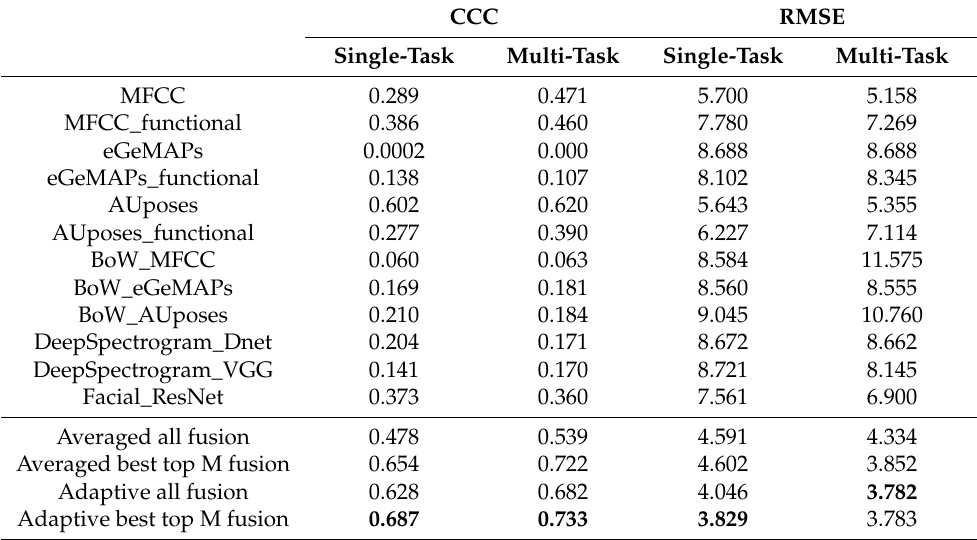
Table 4. Comparison between single modality and multiple modalities fusion and Comparison betweenn averaged multi-modal fusion and adaptive multi-modal fusion. We employ CCC and RMSE as metrics. For every kind of fusion strategy, we perform two ways of late fusion including all fusion and top M fusion . The data in bold means the results with better performance.